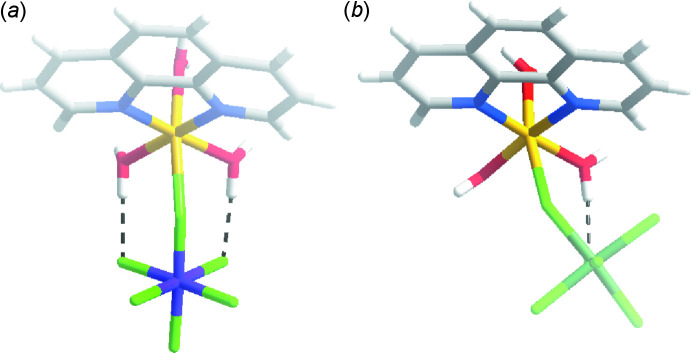
Comparison of the mol­ecular structures of (a) compound (I) and (b) compound (III).